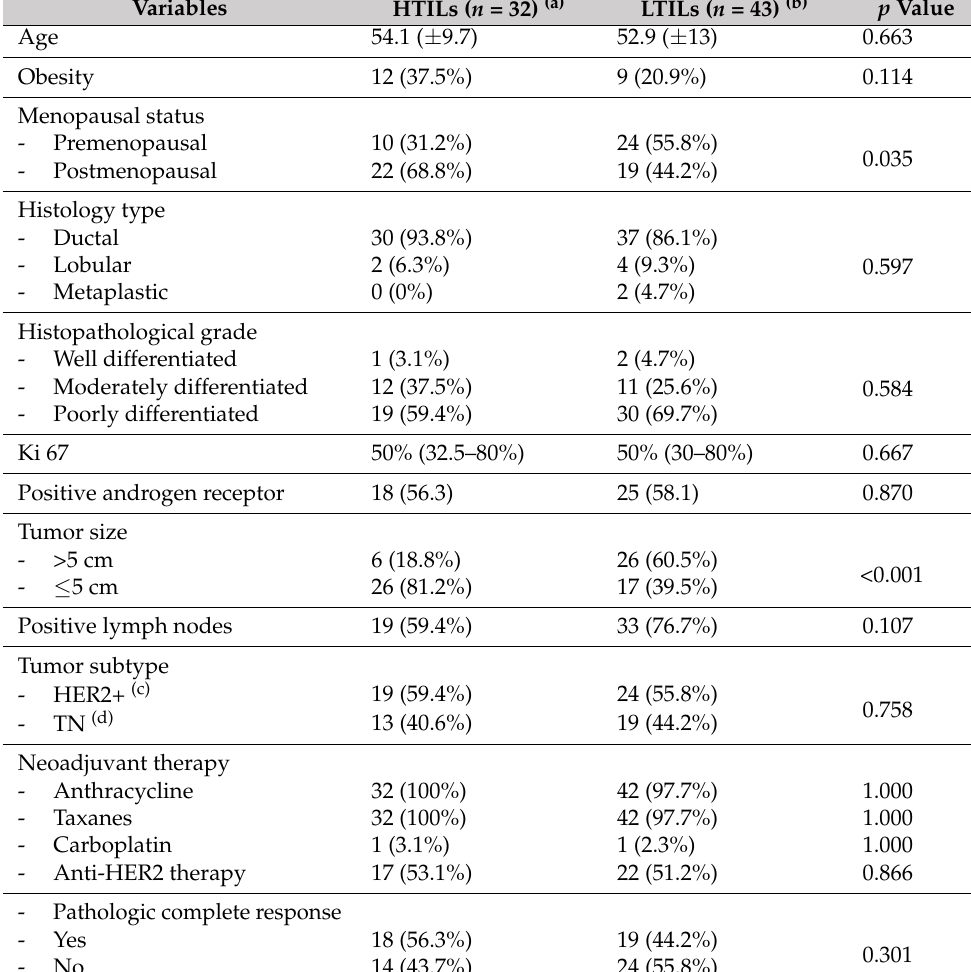
Table 4. Relationship between TILs and clinicopathological characteristics in breast cancer